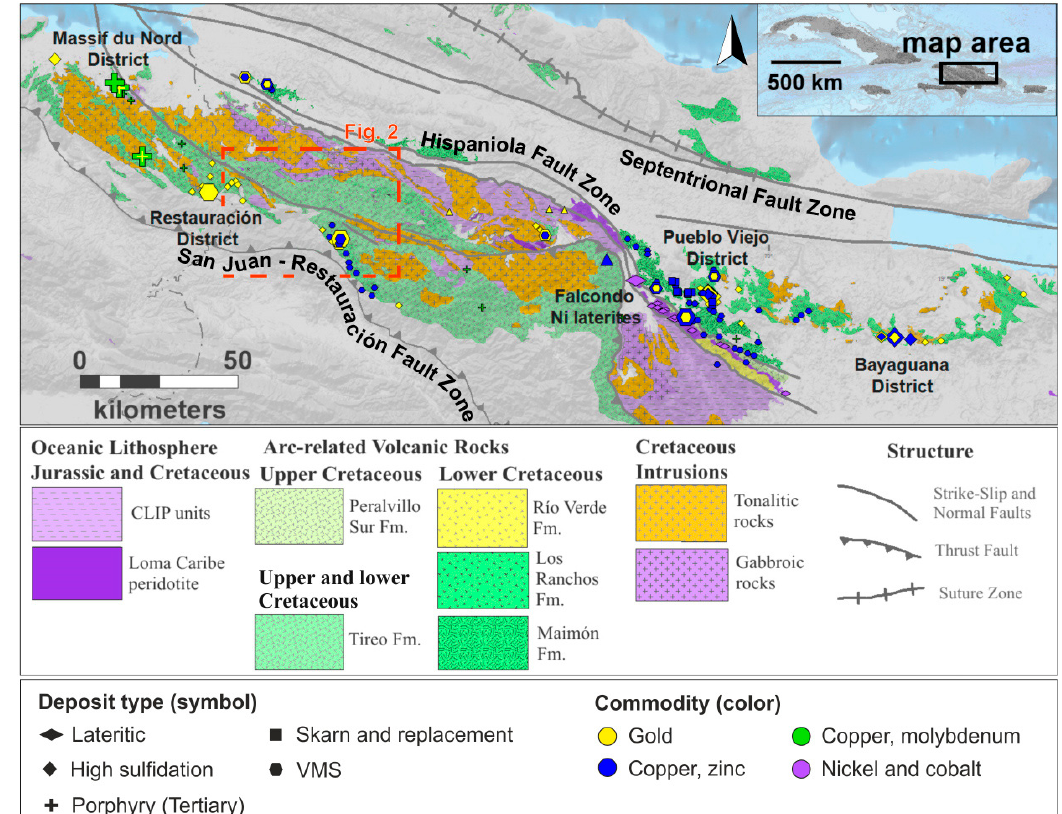
Figure 1. Geologic map of the Cordillera Central and Cordillera Oriental ranges in the Dominican Republic showing the main basement rock units. The geologic base map was modified from Nelson et al. [5]. The red box shows the location of the map in Figure 2.